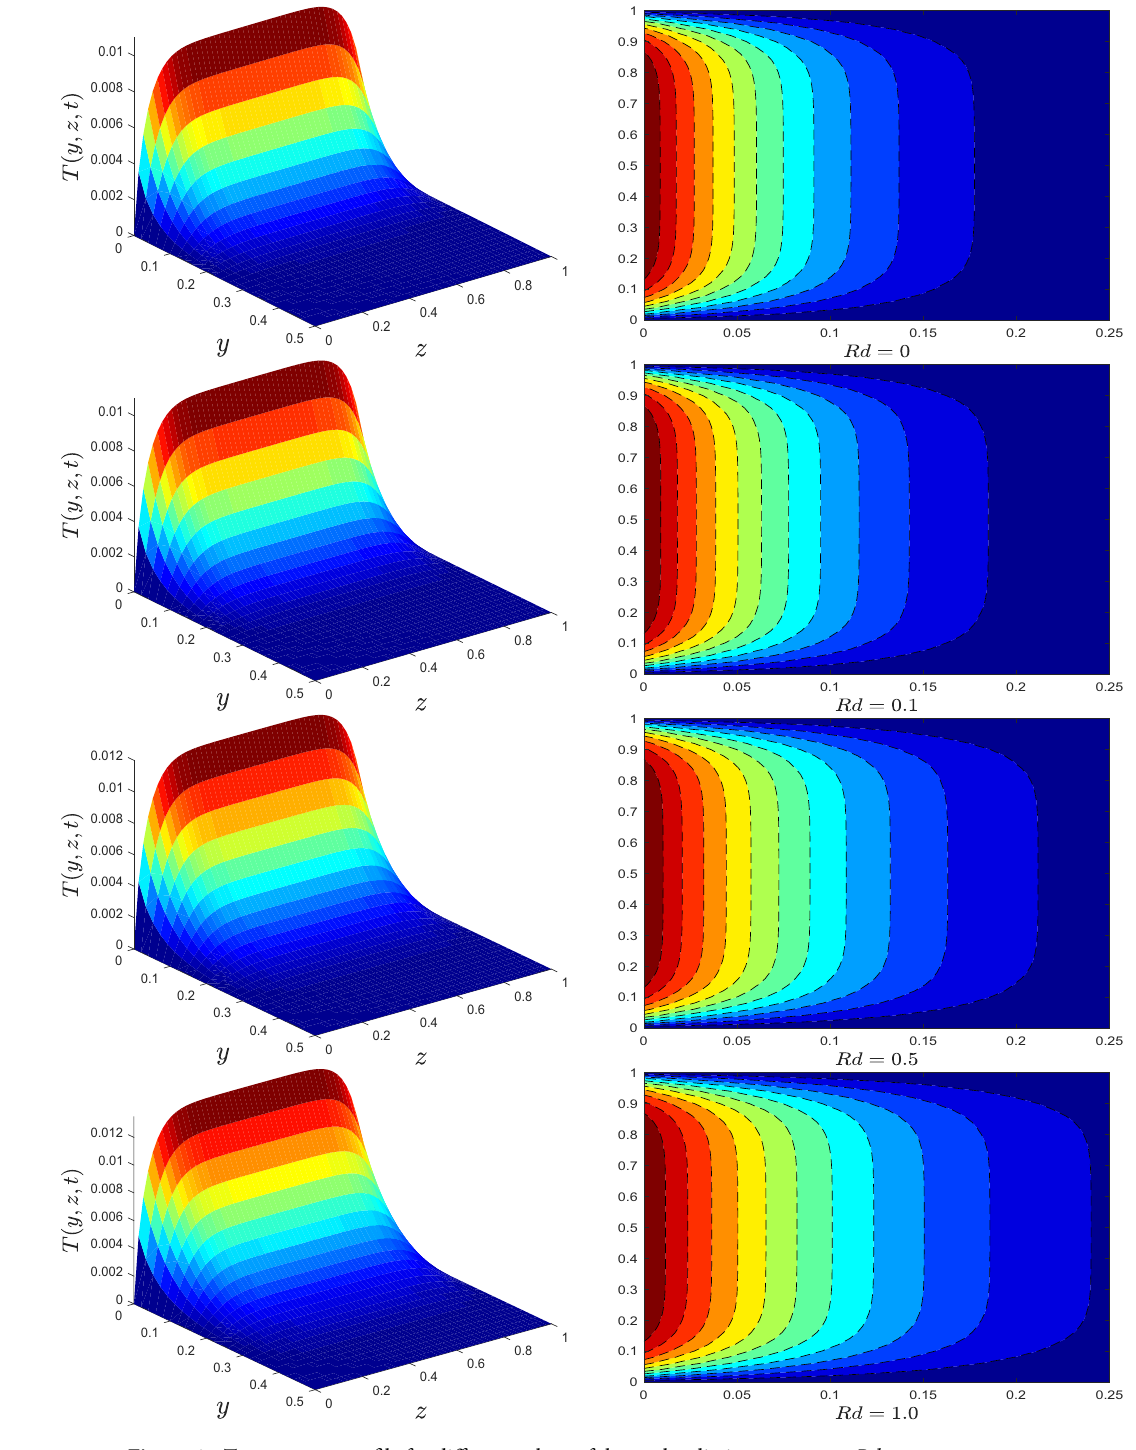
Figure 4. Temperature profile for different values of thermal radiation parameter Rd